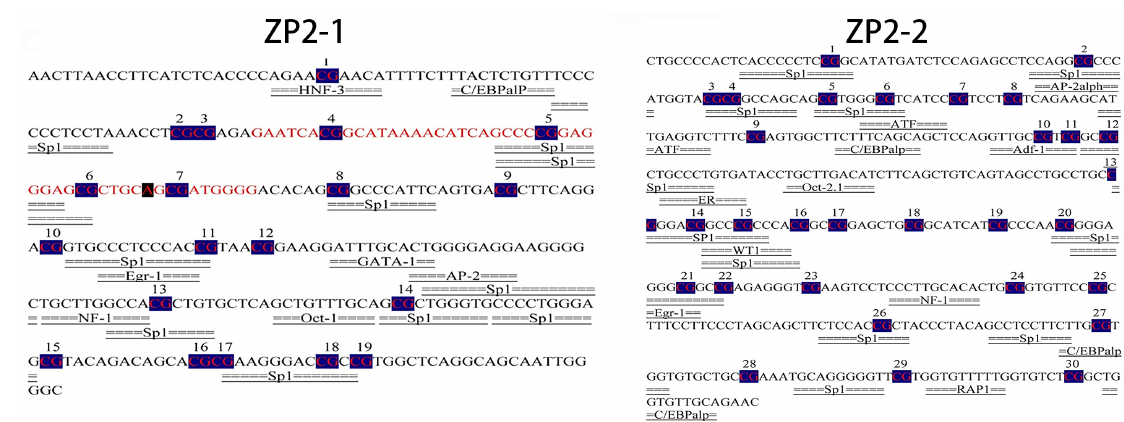
Figure 5. Transcription factor binding site analysis of ZP2-1 and ZP2-2 amplification fragment. The numbers in the figure are 5-mC sites: the 5-methylcytosine site formed after DNA methylation.